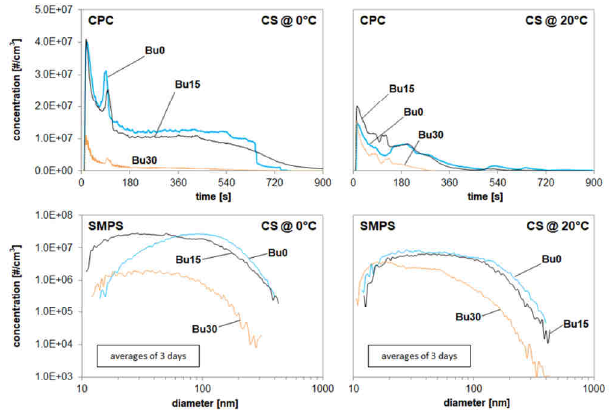
Fig. 15. Comparison of the particles counts during cold start at idling with different fuels, measured with both systems at